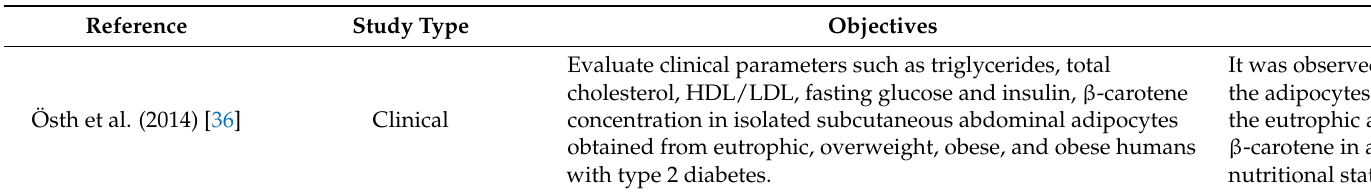
Table 1. Scientific findings related to vitamin A and precursor status and